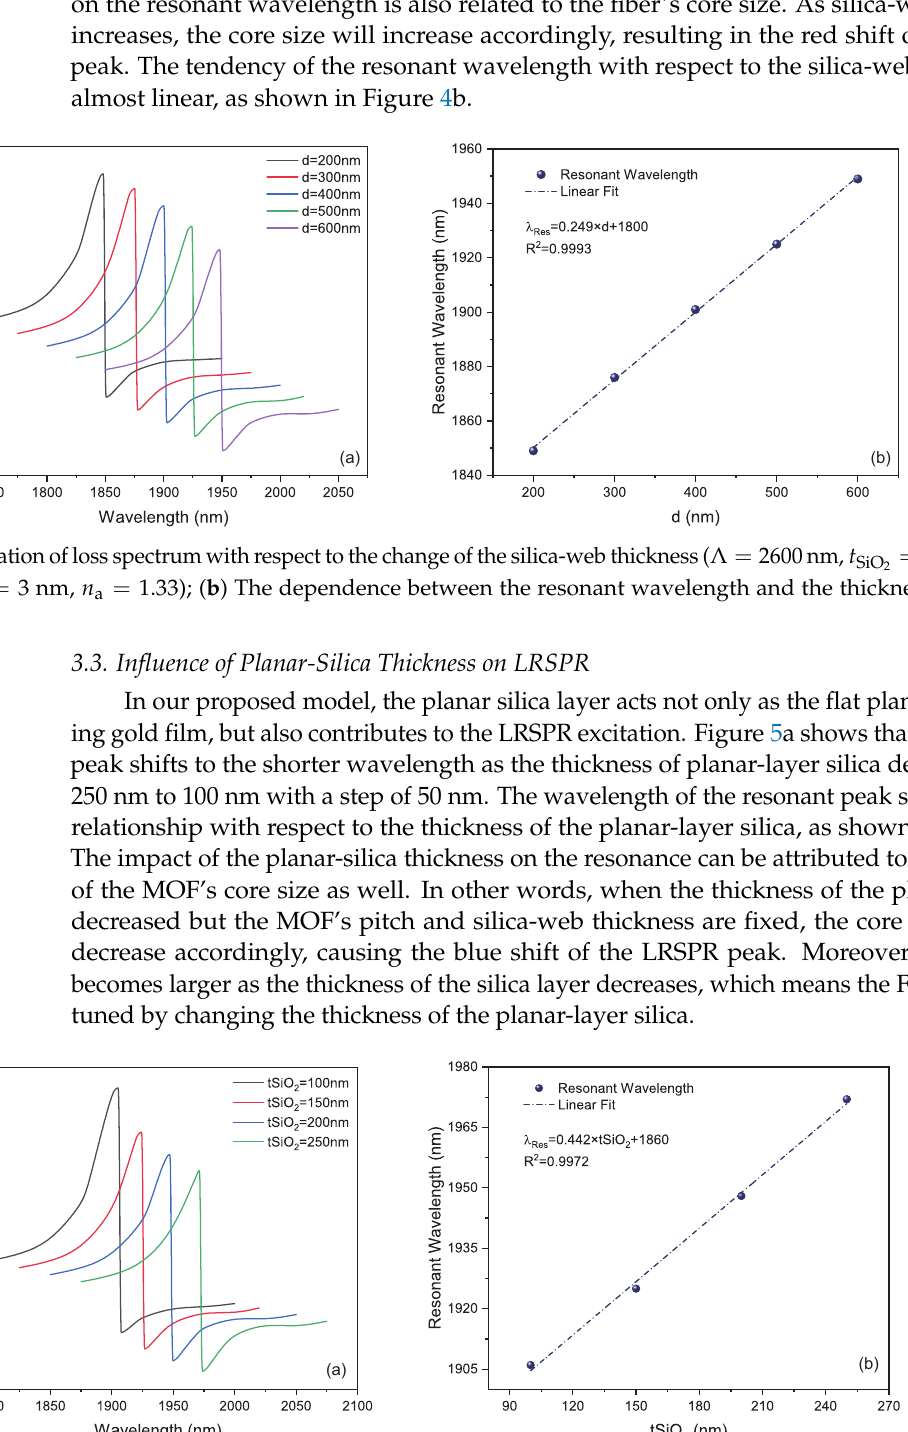
Figure 5. ( a ) The variation of loss spectrum with respect to the change of the thickness of planar-layer silica ( Λ = 2600 nm, = 3 nm, n a = 1.33); ( b ) The relationship between the resonant wavelength and the thickness d = 500 nm, t Au = 70 nm, t TiO 2 of the planar-layer